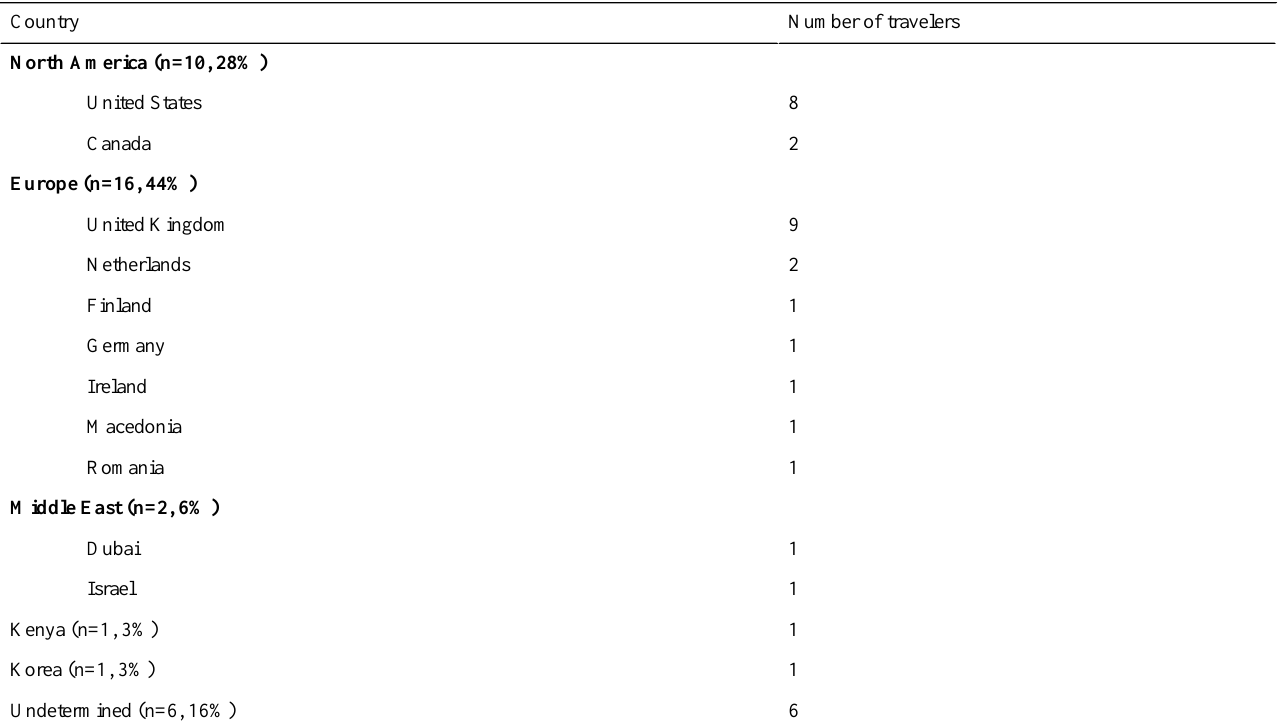
Table 1. Health travelers’country of origin (N=36).